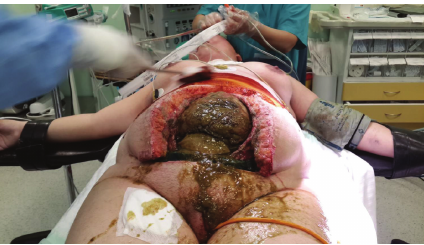
Figure 5: Excessive amount of enteric influents, edematous and fragile intra-abdominal visceral tissue, and excessive adhesions are seen.